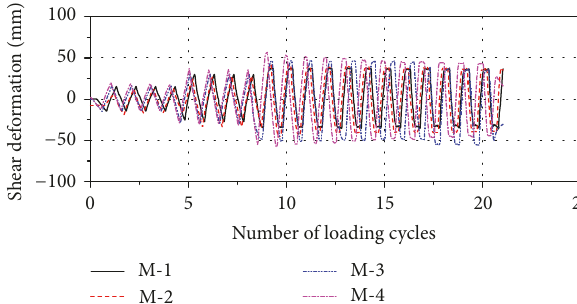
Figure 12: History curve of the shear deformation.